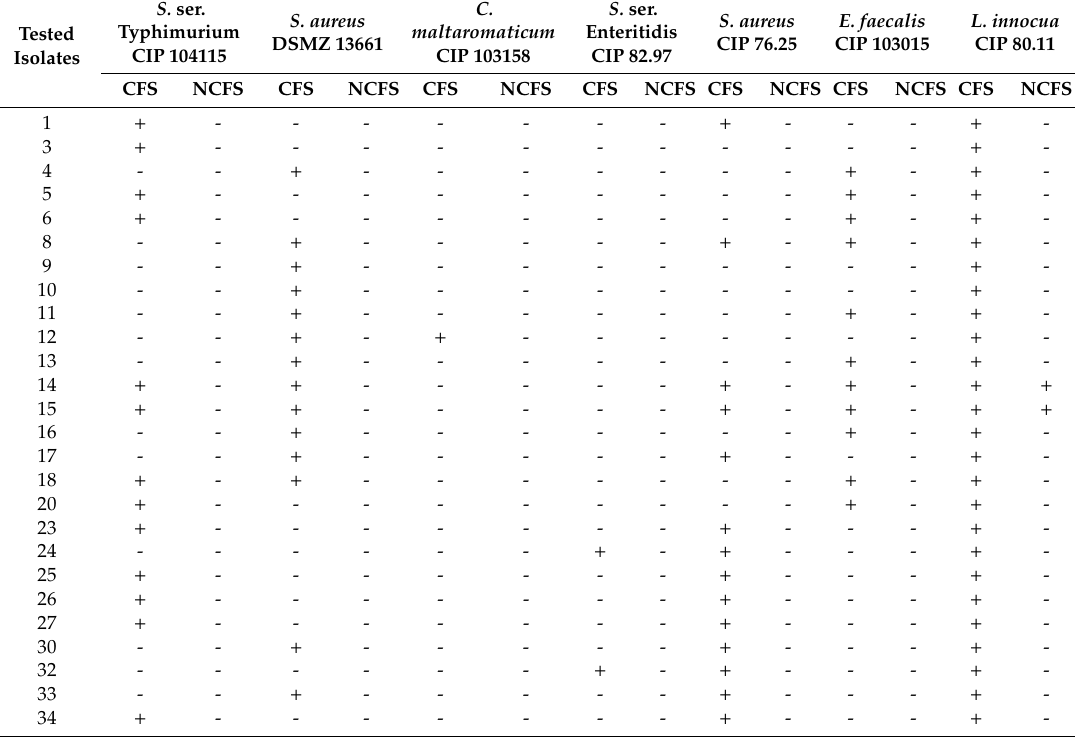
Table 7. Antimicrobial spectrum of CFS and NCFS produced by LAB isolates against related LAB, food-spoilage and foodborne pathogens by the well di ff usion assay. Tested Isolates